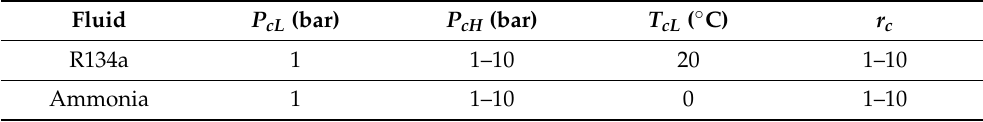
Table 3. Real gases and operating conditions of the